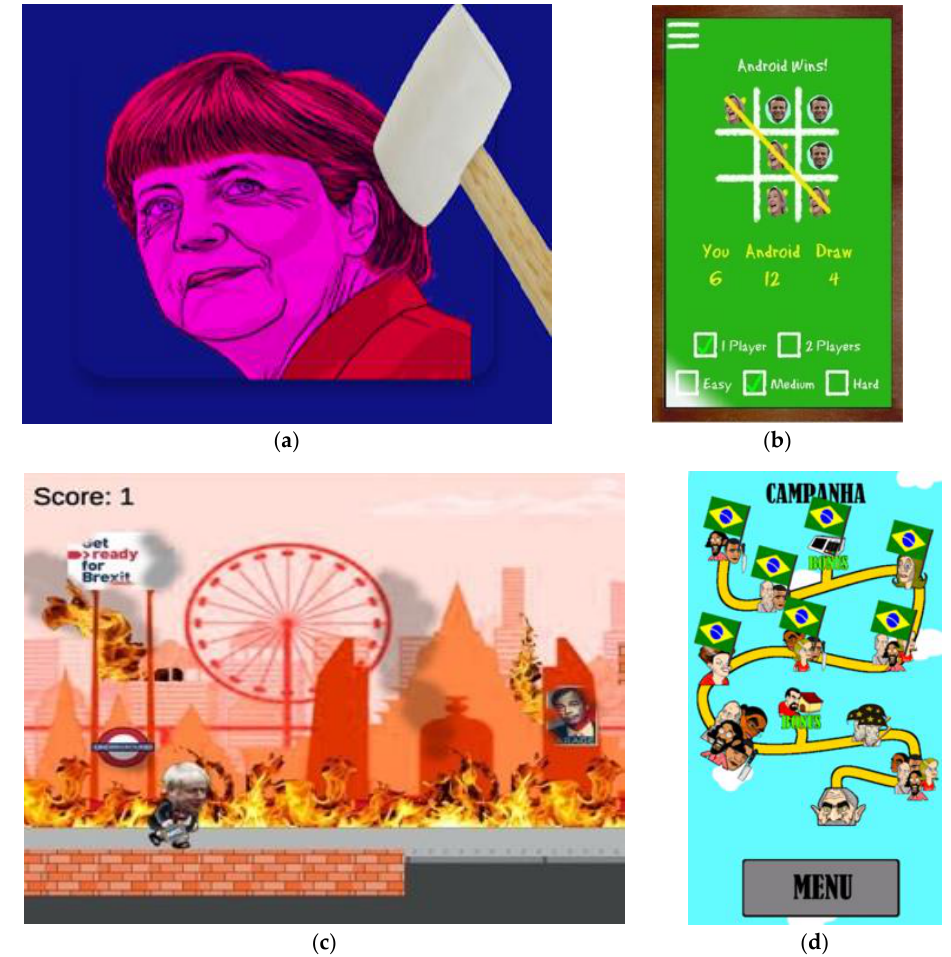
Scheme 1. Manifestation of politicians in popular apps. Source: the respective applications. ( a ) Merkel Tap (Presovsky 2018). ( b ) Macron vs. Le Pen Tic Tac (haijoubdemo 2017). ( c ) Brexit Run (Karma Skid 2020). ( d ) Bolsonaro vs. Petralhada (Irmões Bródi 2018).